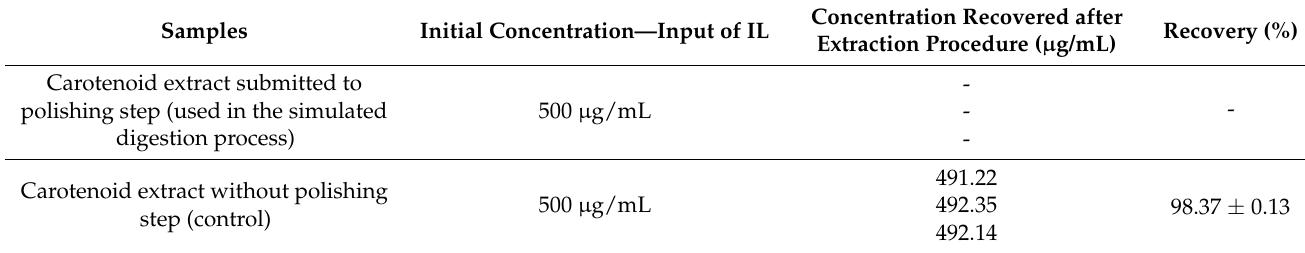
Table 1. Quantification of [C 4 mim][BF 4 ] in carotenoid